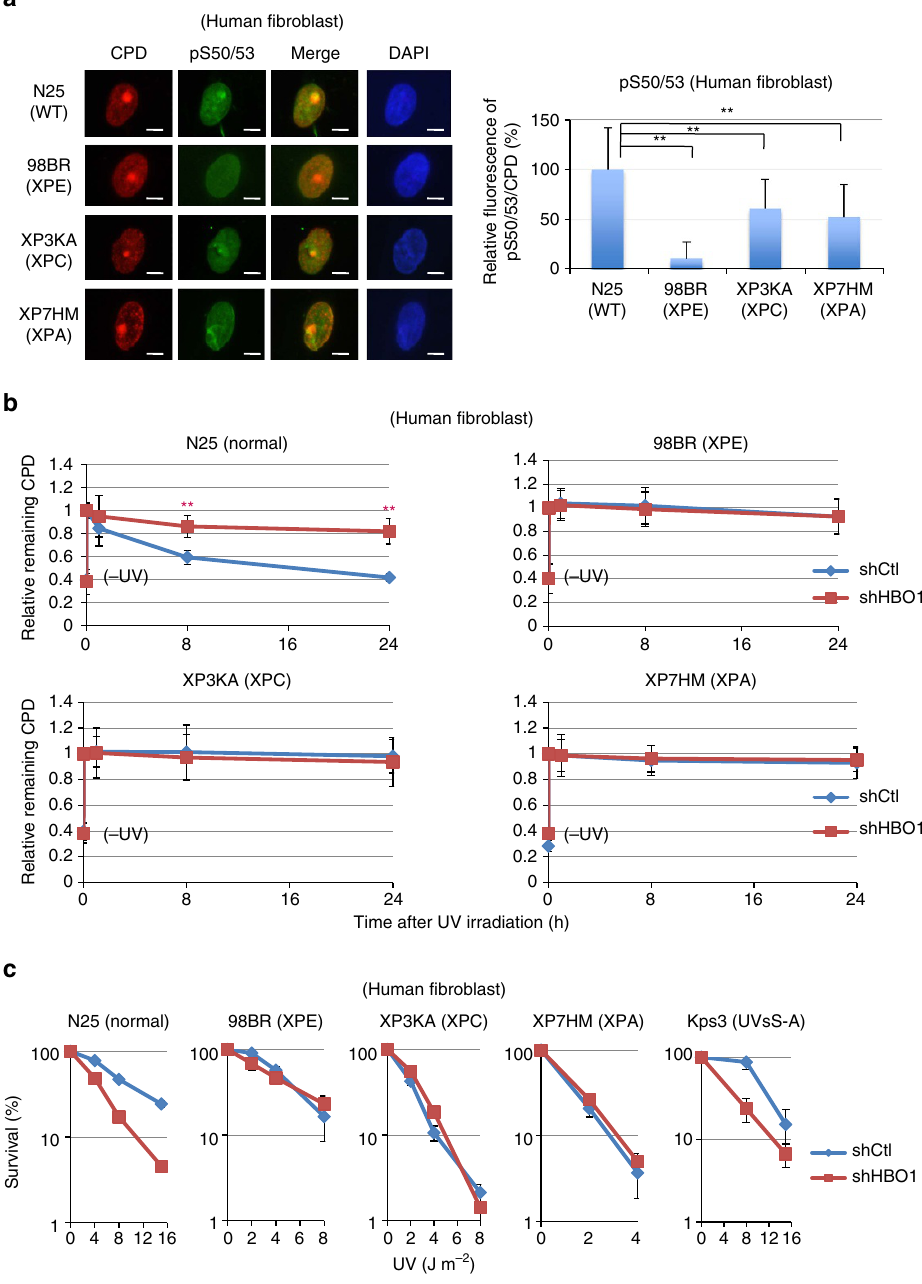
Figure 6 | Phosphorylated Ser50 and Ser53 of HBO1 at sites of ultraviolet-induced damage is involved in canonical GG-NER pathway. ( a ) Fibroblasts derived from normal and XPE, XPC and XPA patients were irradiated with 12Jm (cid:2) 2 local ultraviolet and cultured for 30min. Cells were immunostained with anti-CPD and anti-HBO1 pS50/53 antibodies. The relative pS50/53/CPD intensities of 98BR, XP3KA and XP7HM cells are shown as % of levels in N25 cells. Scale bars, 5 m m. Cells ( n ¼ 30) from three independent experiments; error bars indicate means ± s.d. ** P o 0.01 (Student’s t -test). ( b ) Fibroblasts derived from normal and XPE, XPC and XPA patients were depleted for HBO1 by a shHBO1-expressing lentivirus. Cells were not irradiated (-ultraviolet) or irradiated with 12Jm (cid:2) 2 ultraviolet and cultured for 0, 1, 8 and 24h, and then fixed and immunostained with anti-CPD antibody. Relative intensities of CPD normalized against DAPI are shown as fold of ultraviolet 0h cells. Cells ( n ¼ 50) from three independent experiments; error bars indicate means ± s.d. ** P o 0.01 (Student’s t -test). ( c ) Fibroblasts derived from normal and XPE, XPC, XPA and UVsSA patients were depleted for HBO1 by a shHBO1-expressing lentivirus. Cells were irradiated at the indicated ultraviolet dose, cultured for 2 weeks and then fixed with MeOH/acetic acid and stained with crystal violet solution. The number of colonies were counted and are represented as % of mock-irradiated cells. Three independent experiments were performed. Error bars indicate means ±